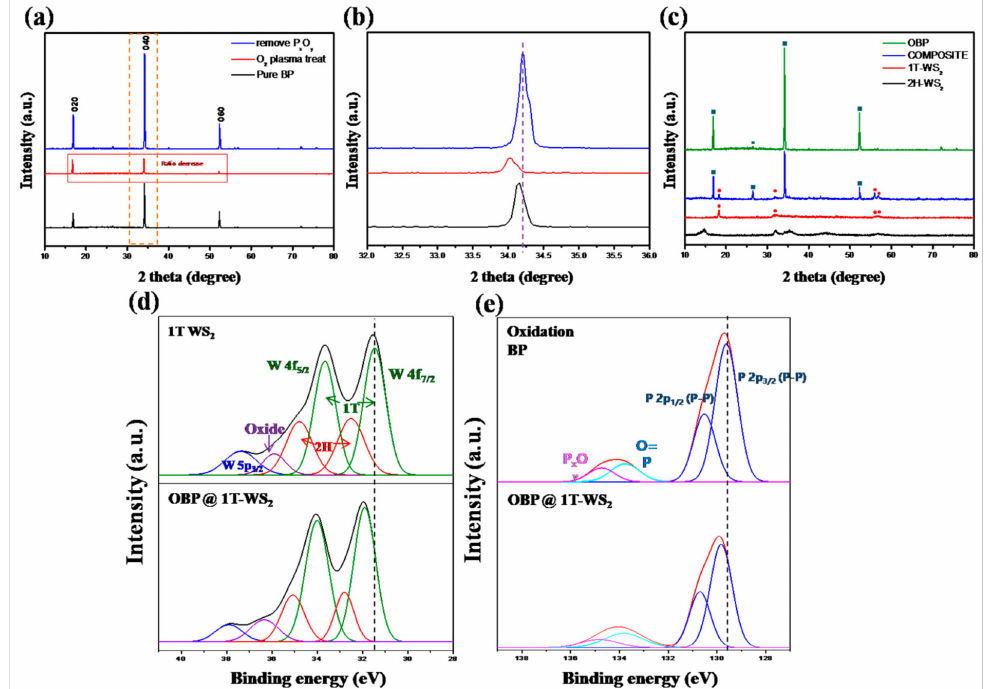
Figure 5. ( a ) XRD data depending on the BP oxidation control. ( b ) XRD data of the dashed square in ( a ), highlighting the 32–36 ◦ peaks. ( c ) XRD data of OBP, 1T-WS 2 , 2H-WS 2 , and the nanocom- posite. X-ray photoelectron spectra of ( d ) W 4f level and ( e ) P 2p level of 1T-WS 2 , OBP, and the